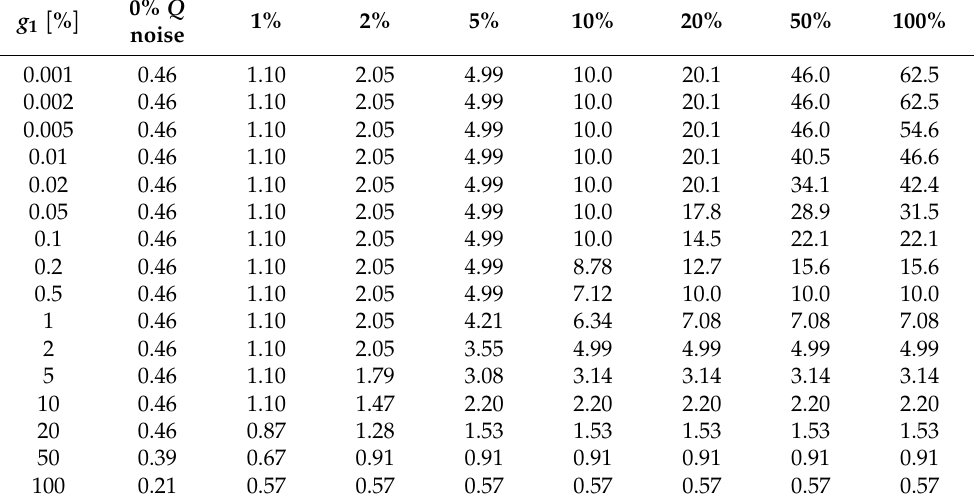
Table 2. Best (lowest) possible resolution of a 1 MeV electron recoil at 0.5 kV/cm as a function of the S1 photon detection efficiency g 1 and wire noise (in semi-log steps). Each entry is averaged over 10 4 simulations in stand-alone NEST, with the effect of delta rays approximated analytically (based on G4). All photons and electrons are included from the interaction, which is thus being treated as a single